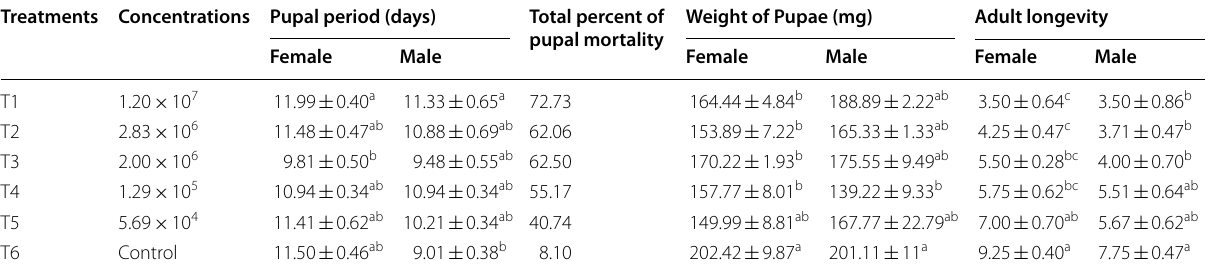
Table 2 Debilitating effect of different concentrations of SpfrNPV on pupal period, pupal weight and adult longevity (mean Spodoptera